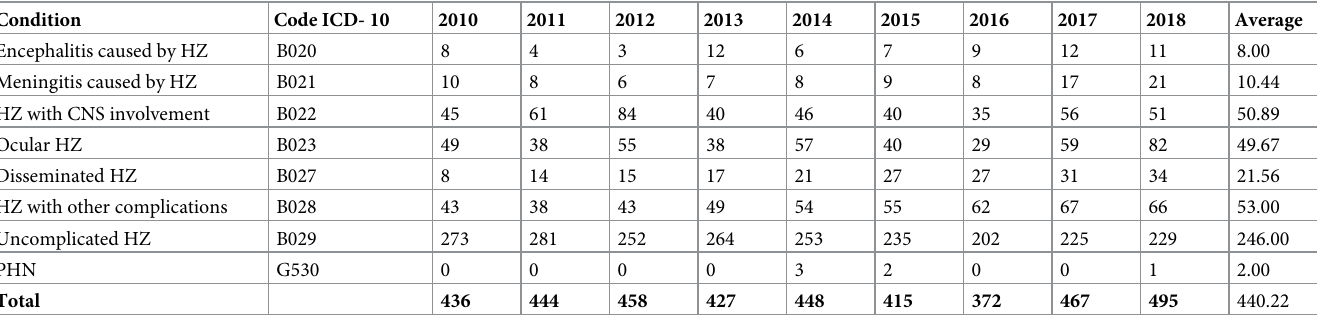
Table 5. Hospital discharges per year per ICD-10 category in Chile